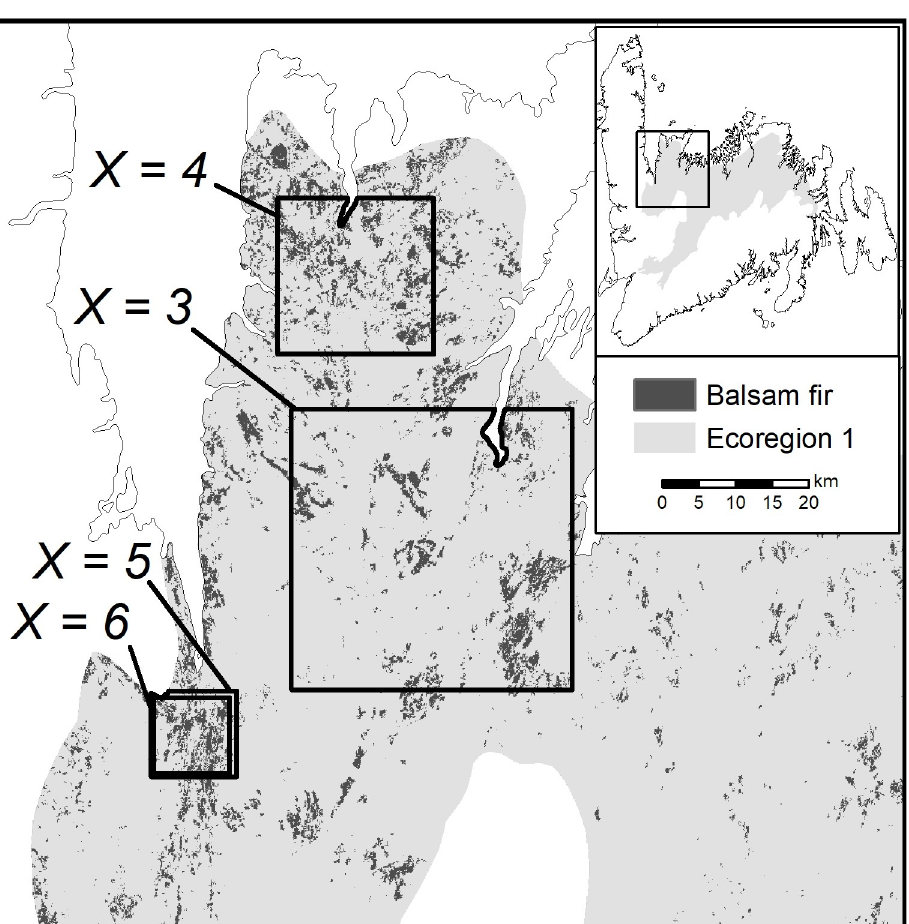
Fig 3. Candidate MDRs from ecoregion 1 that satisfied initial and dynamic conditions. Each MDR was estimated for a disturbance scenario defined by the minimum number of consecutive years of defoliation: X = 3, 4, 5, and 6 years. MDR values are in Table